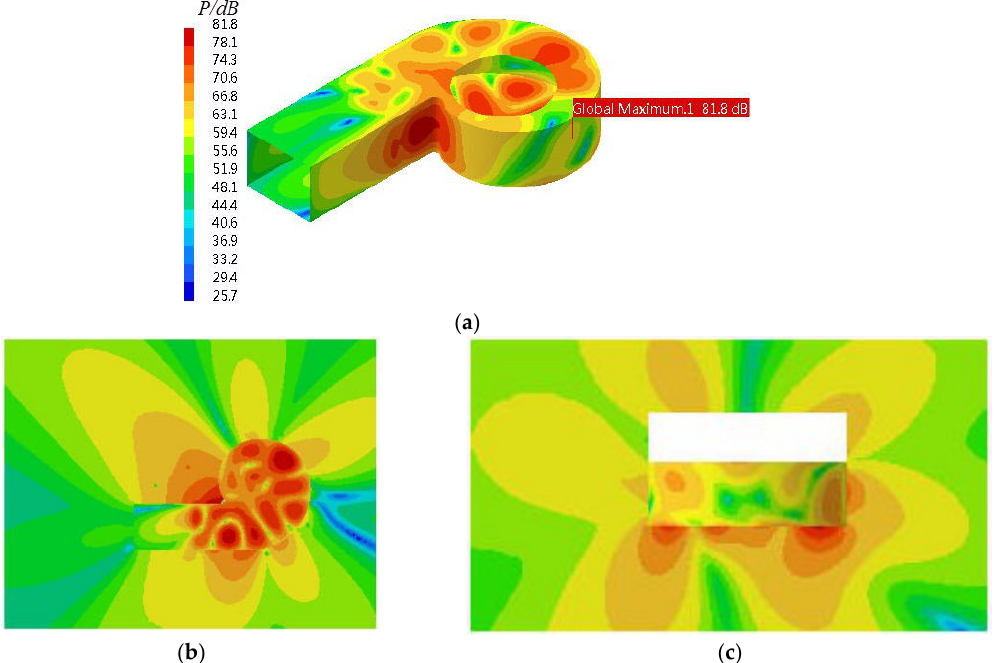
Figure 28. The distribution of vibrational sound radiation of original volute at the fundamental frequency. ( a ) The whole volute body; ( b ) XY section; ( c ) ZY section.